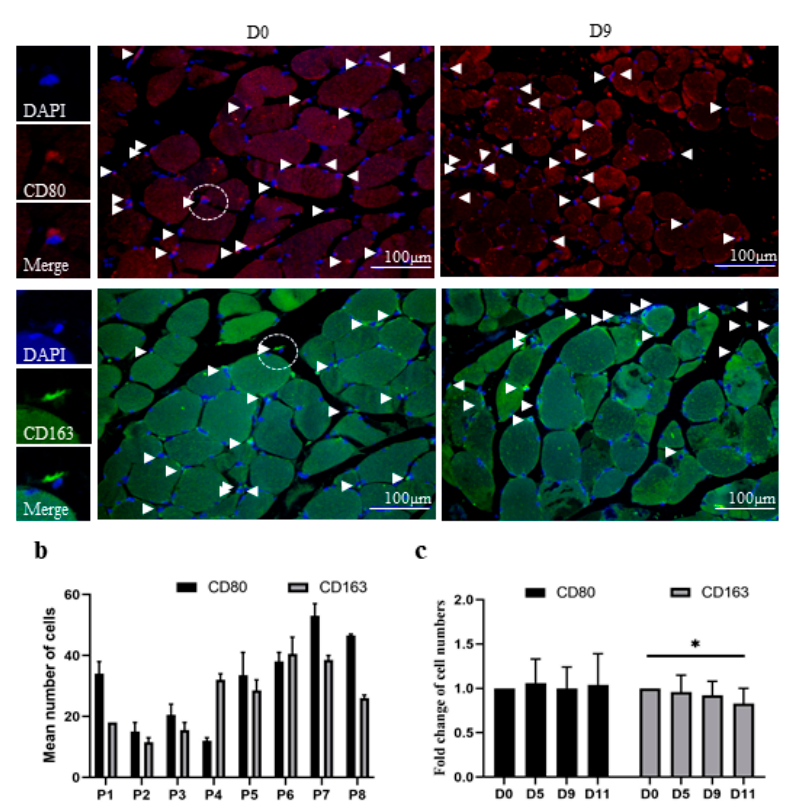
Figure 2. Resident macrophages in human skeletal muscle tissue maintained in vitro for 11 days. Skeletal muscle tissue sections were analyzed for the presence of M1 (CD80-positive) or M2 (CD163- positive) macrophages using immunofluorescence and DAPI staining. ( a ) The images are representative of a total of 32 different sections from 8 participants before (D0) or after 5 (D5), 9 (D9), or 11 (D11) days of maintenance in vitro. Sections from a single participant at D0 and D9 are presented and labeled at the top of each image. White arrowheads indicate positive cells. The white scale bars represent 100 µm. Left panels present fluorescence images at higher magnification of single M1 macrophages (red), M2 macrophages (green), DAPI (blue), and merged signals, as depicted. The mean number of positive cells was obtained from two randomly selected fields of 0.24 mm 2 within cross-sectional areas of muscle fibers. ( b ) The diagram shows the mean numbers of CD80-positive (black bars) and CD163-positive (gray bars) macrophages in 0.24 mm 2 of muscle fibers from individual participants (P1–P8) at D0 (Supplementary Table S1). ( c ) The diagram shows the mean fold change, which was determined by normalizing the number of positive cells in samples from each participant at D0, D5, D9, and D11 to that at D0. Thus, D0 was set to one for every participant and for the mean change at D0 (Supplementary Table S2). p ≤ 0.01 (*).